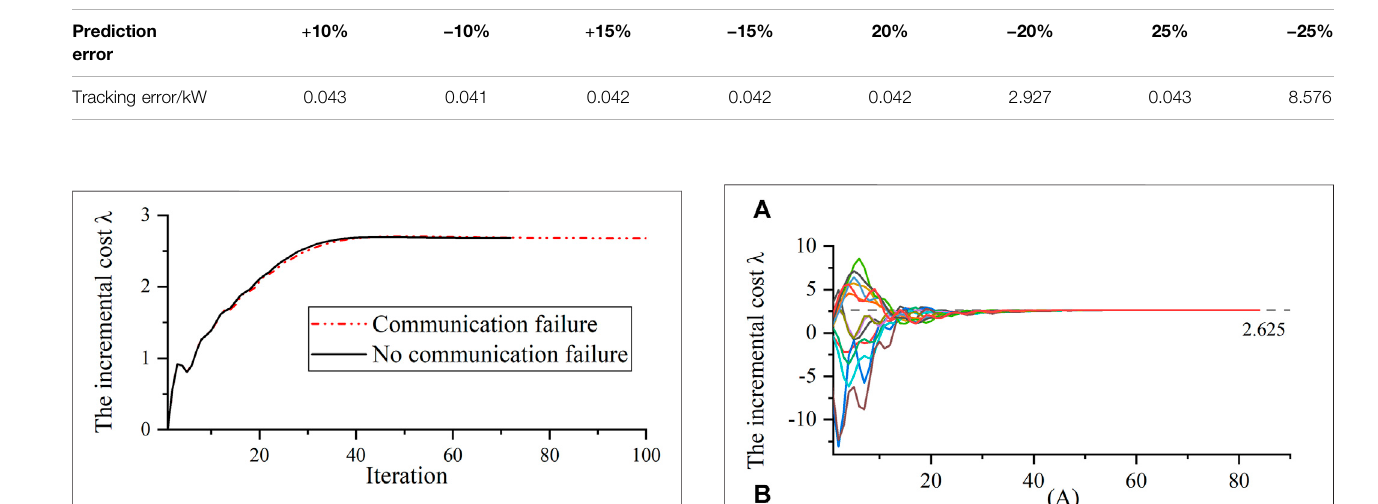
FIGURE 8 | The convergence process of bus 1.